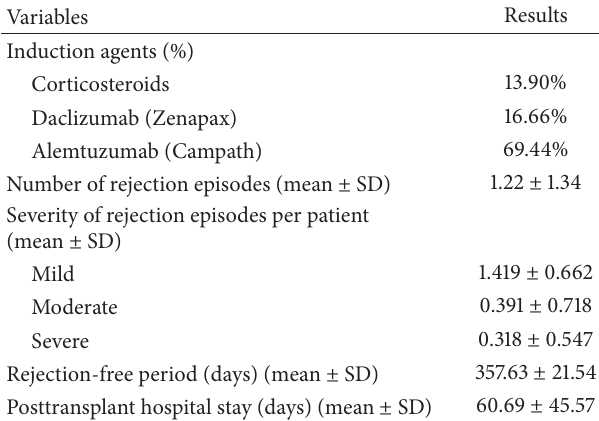
Table 4: Peri- and postoperative data.